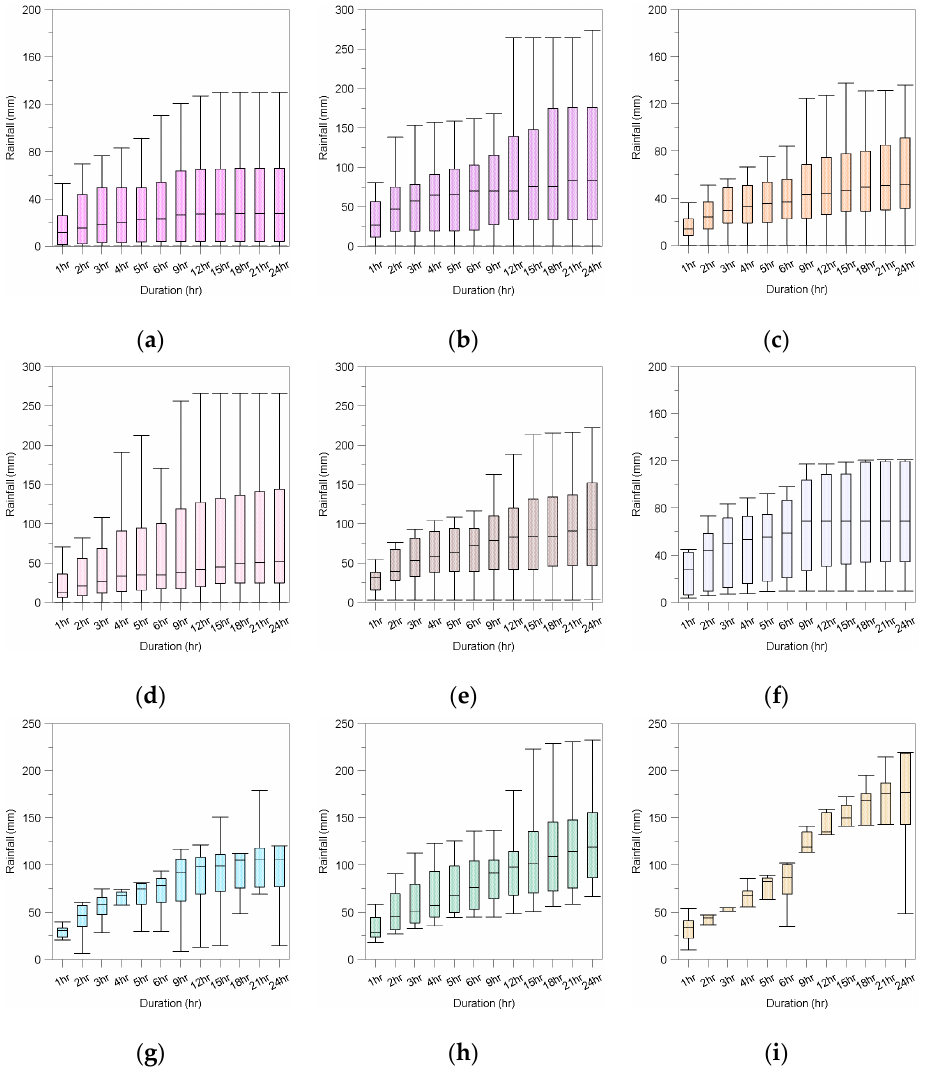
Figure 5. Maximum rainfall by time duration for different lengths of disasters: ( a ) 1-day; ( b ) 2-day; ( c ) 3-day; ( d ) 4-day; ( e ) 5-day; (f ) 6-day; ( g ) 7-day; ( h ) 10-day; and ( i ) 13-day.